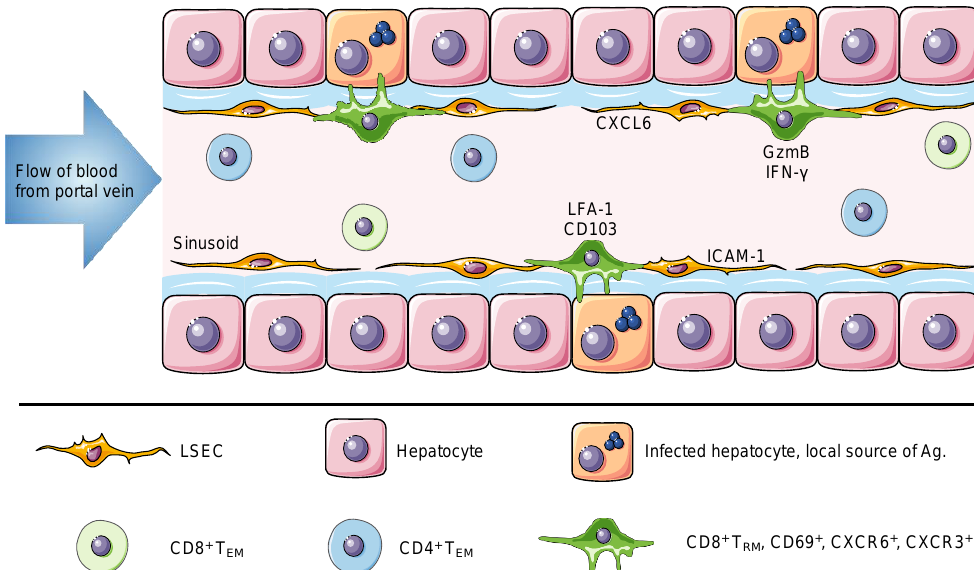
Figure 1. The liver is a unique niche for tissue resident memory cells. The portal vein delivers antigen-rich blood from the gastrointestinal tract and spleen to the liver. This blood flows through the liver hepatic sinusoids lined with a thin layer of fenestrated liver sinusoidal endothelial cell (LSEC). Liver T RM cells are localized within the hepatic sinusoids, where they remain long-term and do not recirculate despite direct connection to the circulatory system and constant exposure to the blood. The expression of ICAM-1 and CXCL16 by LSEC can promote the retention of lymphocytes, through interactions with LFA-1 and CXCR6, respectively. Murine and human T RM cells in the liver express CD69, CXCR6, CXCR3 and high levels of LFA-1. Of note, human but not murine T RM cells express CD103. It has been suggested that this difference is associated with a broad versus a restricted expression of E-cadherin by human and murine hepatocytes, respectively. Intrahepatic lymphocytes including circulating and resident memory cells can access the surface of hepatocytes through LSEC fenestrae and exert effector functions. Using cytoplasmic protrusions, lymphocytes probe hepatocytes for the presence of antigen and can release factors such as GzmB and IFN-γ to promote hepatocyte killing. In murine studies, liver T RM cells can be generated through different vaccination strategies to confer protection against Plasmodium parasites and in humans they have been associated with disease control against HBV and HCV.